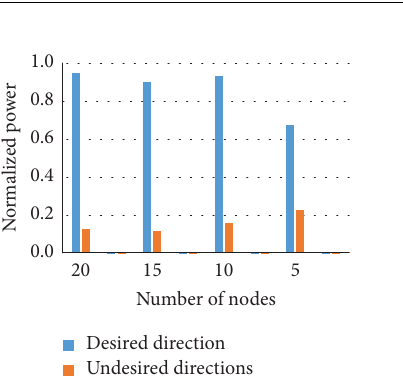
Figure 13: Average normalized power in the desired and undesired directions against the count of nodes (as per the data given in Table 12).